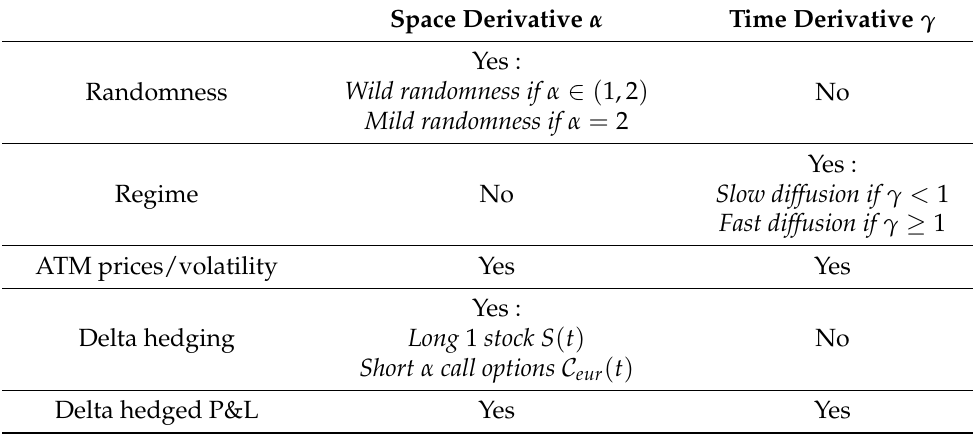
Table 1. The RFFD ( α , γ ) model: Impacts of the fractional